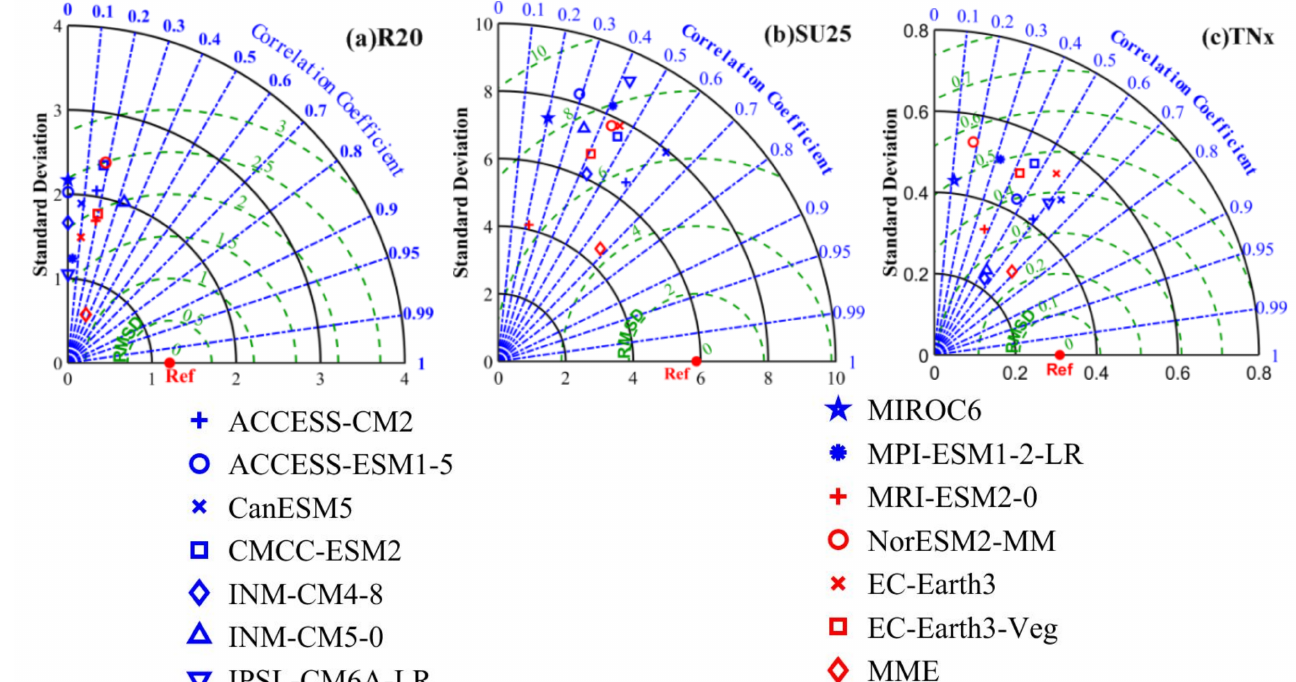
Figure 10. Taylor diagram of extreme climate index model evaluation based on the optimal model (ref is extreme climate index calculated from historical data, ( a ). R20: Number of moderate precipitation days, ( b ). SU25: Hot summer days, ( c ). TNx: An extremely high daily minimum